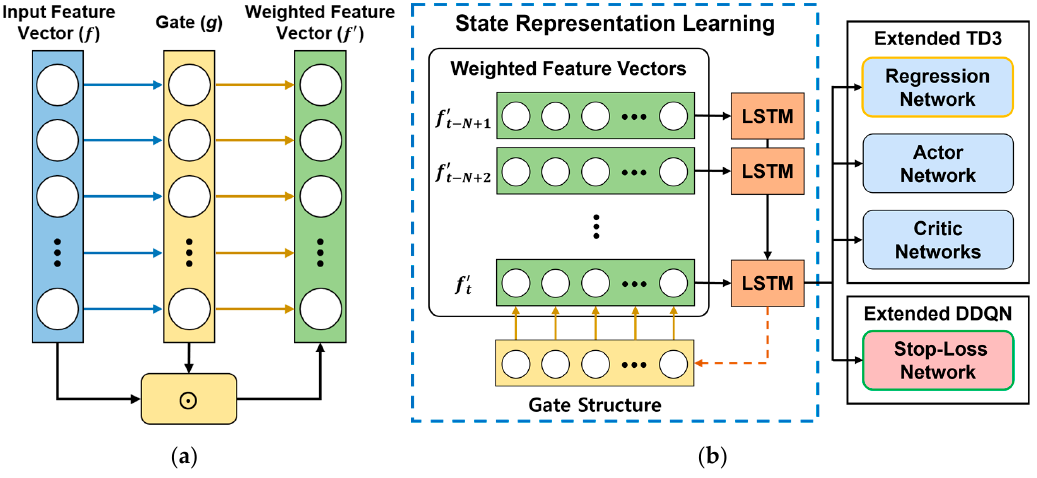
Figure 5. State representation learning. ( a ) Gate structure. ( b ) Architecture of the SRL.